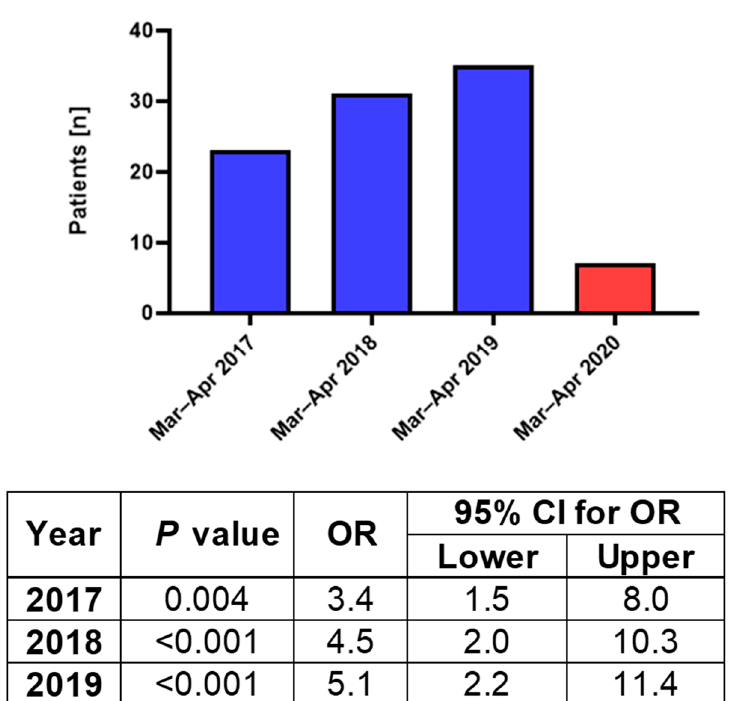
Figure 2. Trauma patients admitted to the Galilee Medical Center during March and April of 2017, 2018, and 2019 compared to the same period in 2020 corresponding to the COVID–19 lockdown, presented with univariate logistic regression analysis.